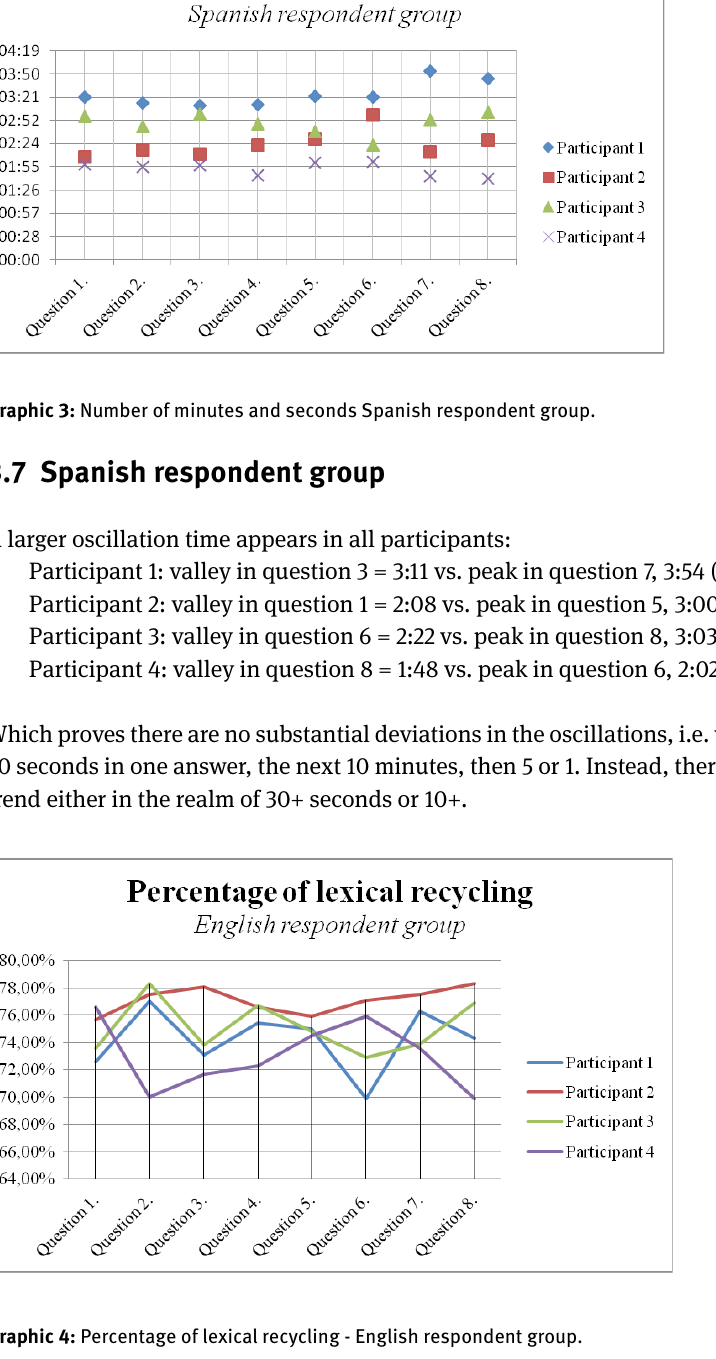
Graphic 4: Percentage of lexical recycling - English respondent